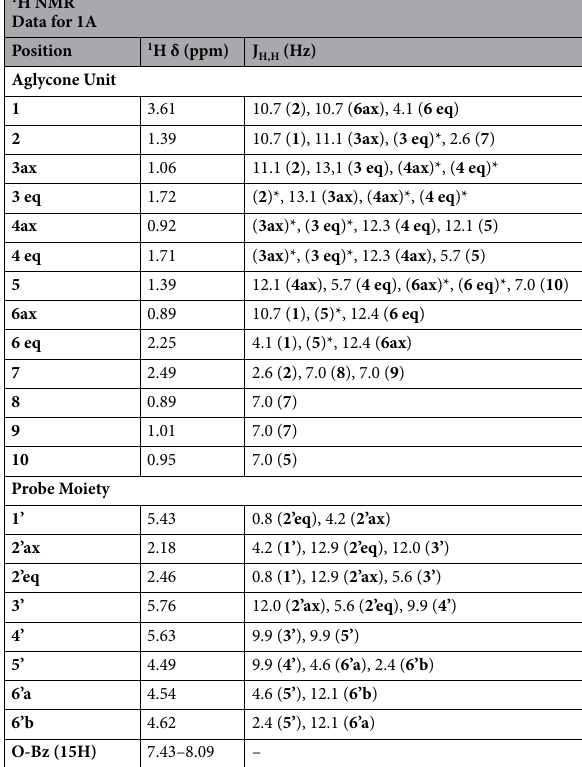
2D ROESY NMR Data for 1A